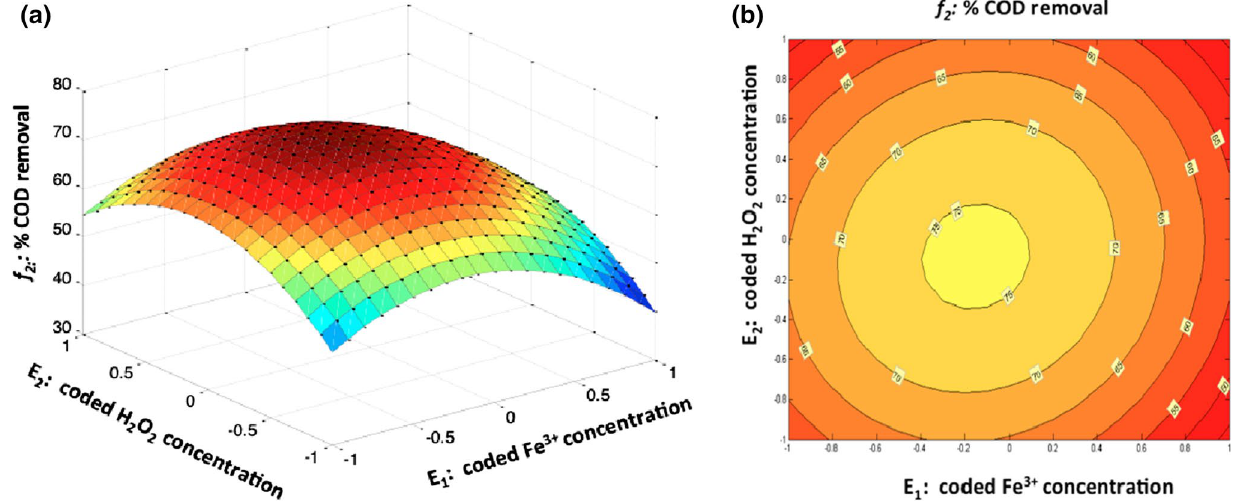
Fig. 4 Plots of COD removal response with respect to Fe 3+ dose and H 2 O 2 dose of photo-Fenton reaction a 3D surface plot, b 2D contour